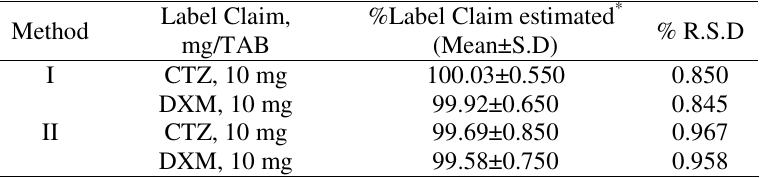
Table 2. Results of commercial formulation analysis